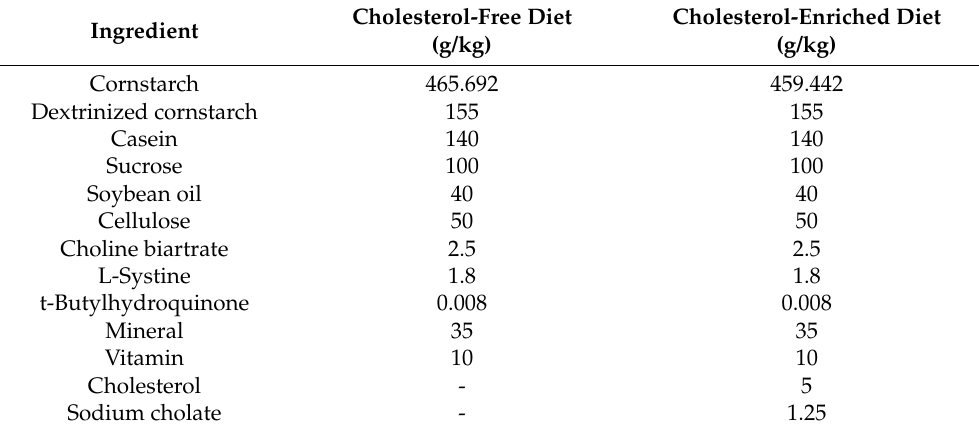
Table 3. Composition of the experimental